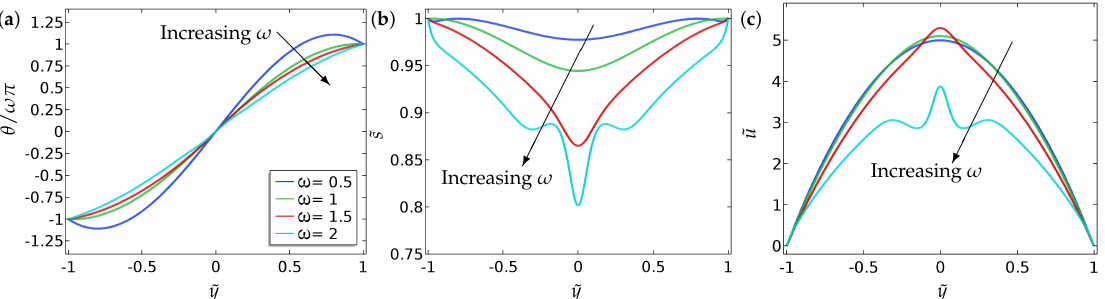
Figure 6. The effect of the winding number ω on ( a ) the director orientation ( θ ), ( b ) the order parameter (˜ s ) and ( c ) the velocity ( ˜ u ), at equilibrium ( ˜ t = 10 ) . In this case, we have considered the symmetric boundary condition in θ (Equation (15)). The values of the parameters used are L ∗ = 10 − 3 , ˜ p x = L 2 = 1, and L 1 = 10 − 6 . The legends of all the sub-figures are the same as in ( a